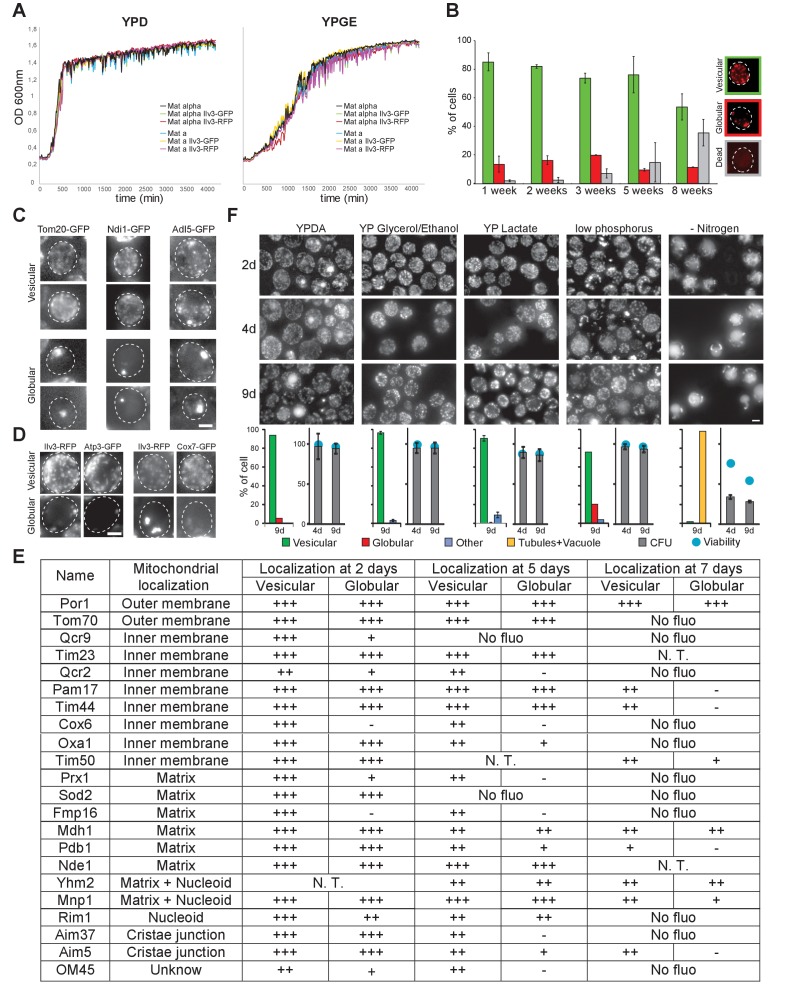
Mitochondrial network organization in WT cells experiencing an extended period of non-proliferation or upon starvation for various nutrients and localization of various mitochondrial proteins in non-proliferating cells.(A) Proliferation in YPD or YPGE of WT cells of the indicated genotype monitored by measuring OD600nm as a function of time. (B) Mitochondrial network organization of WT cells expressing Ilv3-RFP experiencing an extended period of non-proliferation. Cells with a vesicular (green), a globular (red) or no Ilv3-RFP signal (grey) were scored (n > 300, N = 2). (C) Tom20-GFP, Ndi1-GFP and Adl5-GFP localization in WT cells grown for 4 d in YPD. (D) Sdh2-GFP or Atp4-GFP localization in WT cell expressing Ilv3-RFP grown for 7 d in YPD. (E) Localization of various mitochondrial proteins fused to GFP (endogenous locus) and expressed in WT cells grown for the indicated time in YPD. (+) indicates that the protein is detected within the mitochondria of each cell category, (-) indicates that no fluorescence was detected in a specific cell category, (no fluo) means that no fluorescence was detected whatever the cell category, (N.T.) means not tested. (F) Mitochondrial network organization in WT cells expressing Ilv3-RFP grown in the indicated medium and imaged after 2, 4, 9 days. Graphs present the mitochondria organization at 9 days (left, n > 200, N = 2), cell viability and cell capacity to form a colony (right, viability: n > 200, N = 2; CFU: n = 750, N = 9). Of note, more than 95% of the cells grown 7 days in YPGE were individually able to re-enter proliferation after re-feeding on microscope pad.10.7554/eLife.35685.004Figure 1—figure supplement 1—source data 1.Cell category scoring for each replicated experiment in Figure 1—figure supplement 1 panel A, B and F.